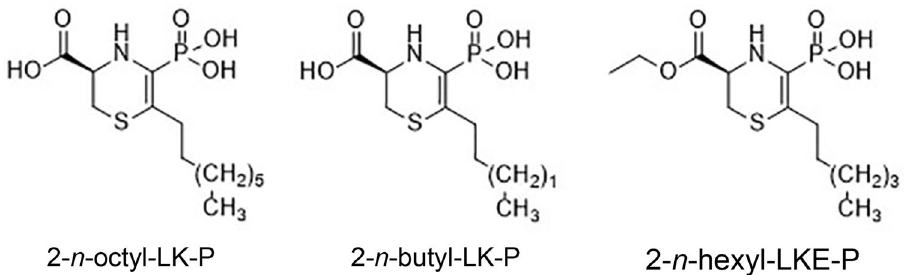
Figure 1. Chemical structures of lanthionine ketenamine (LK) analogs used in this study: 2- n -octyl-LK-P, 2- n -butyl-LK-P, and 2- n